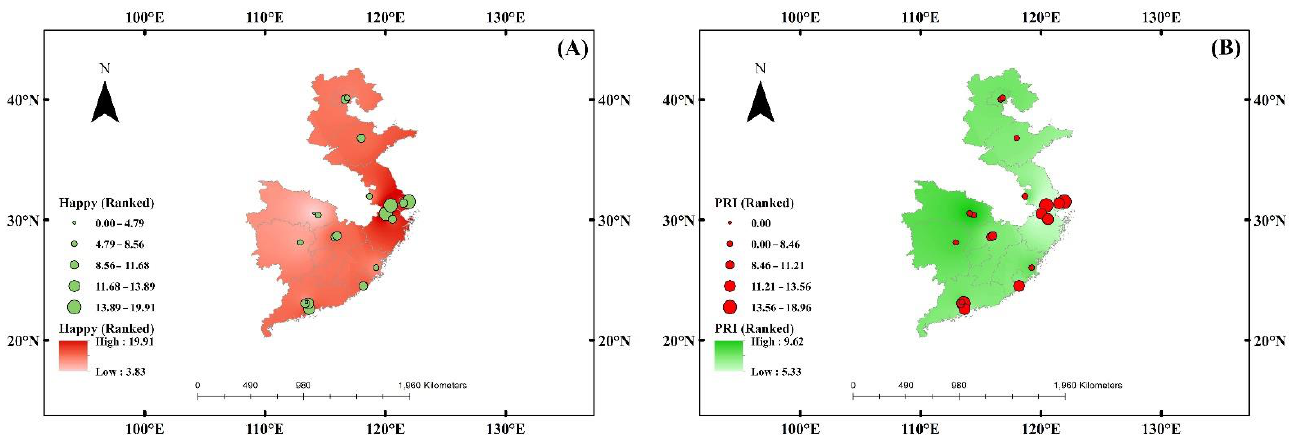
Figure 7. Spatial patterns of optimized distributions of happy ( A ) and positive response index (PRI) ( B ) scores using regressed scores against landscape metrics (Figure 6) in multivariate linear regression models (Table 4).